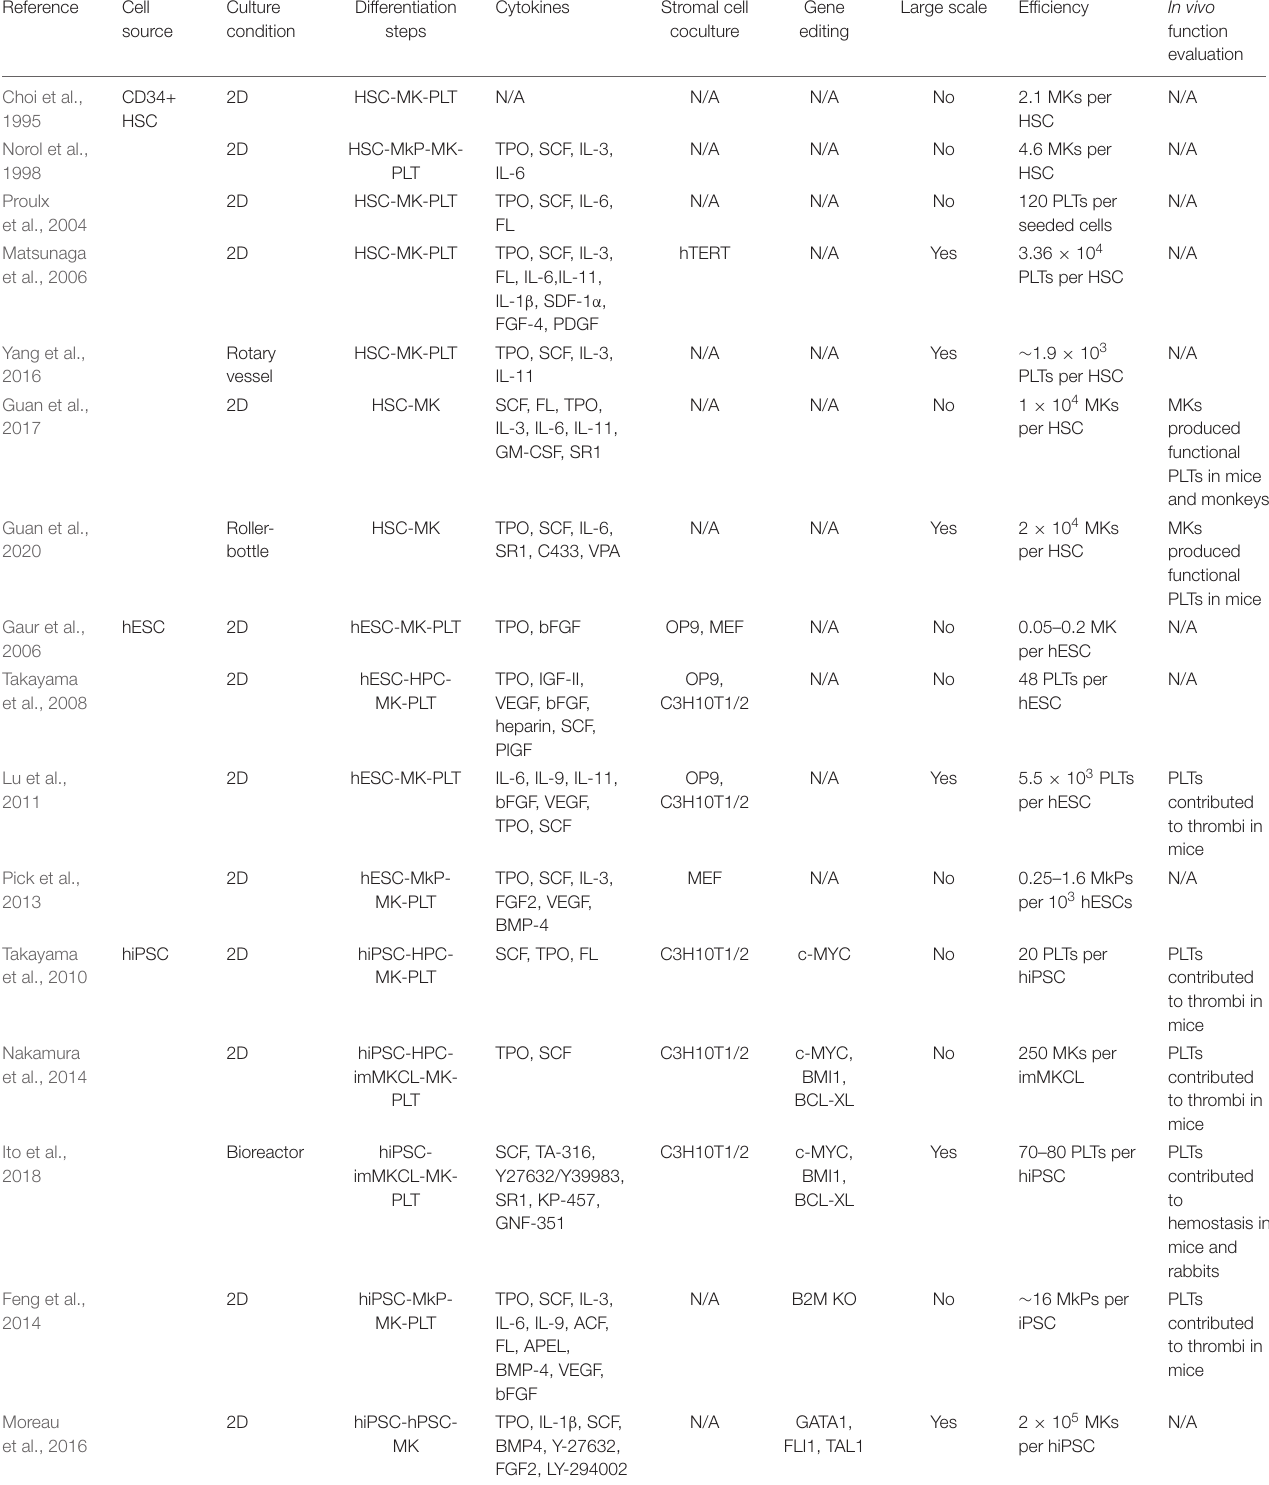
TABLE 1 | Summary of current methods for in vitro generation of megakaryocytes and platelets from different type of